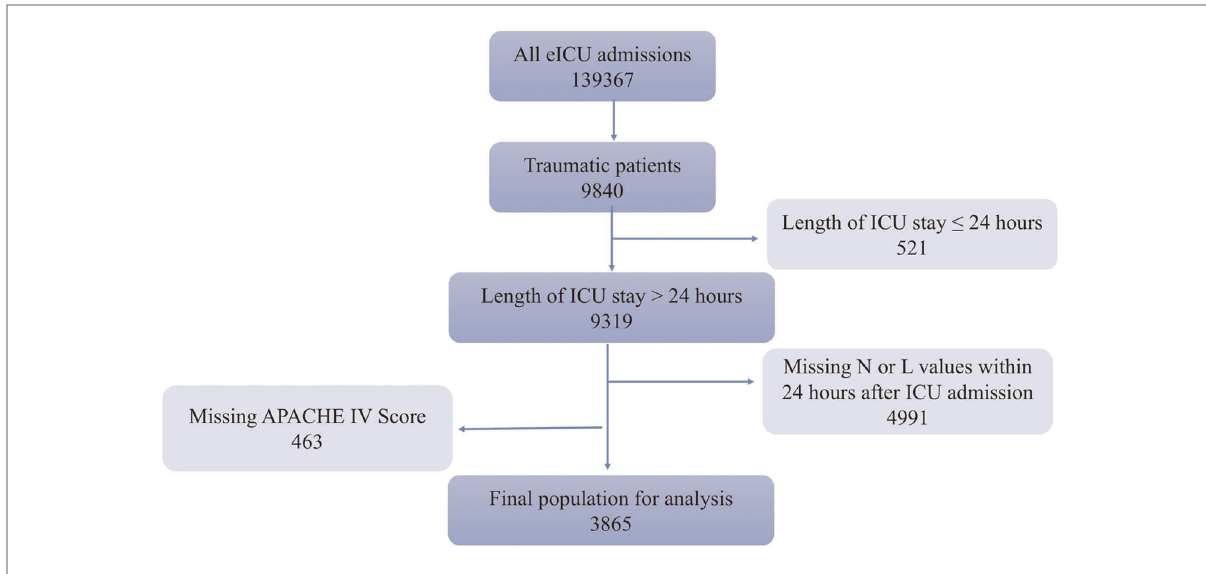
FIGURE 1 Flowchart of study cohort